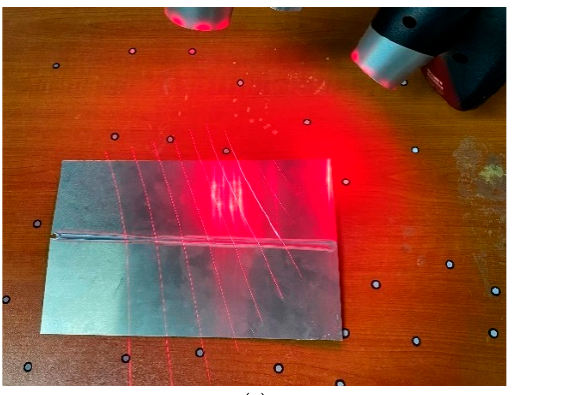
( d ) Figure 16. Comparison between the scanned form of the diagram of the sheet distortion and the numerical simulation results: ( a ) scanning diagram of conventional welding; ( b ) diagram of the sim- ulation results of conventional welding; ( c ) scanning diagram of welding with a trailing hybrid high- speed gas fluid field; ( d ) diagram of the simulation results of welding with a trailing hybrid high- speed gas fluid field.